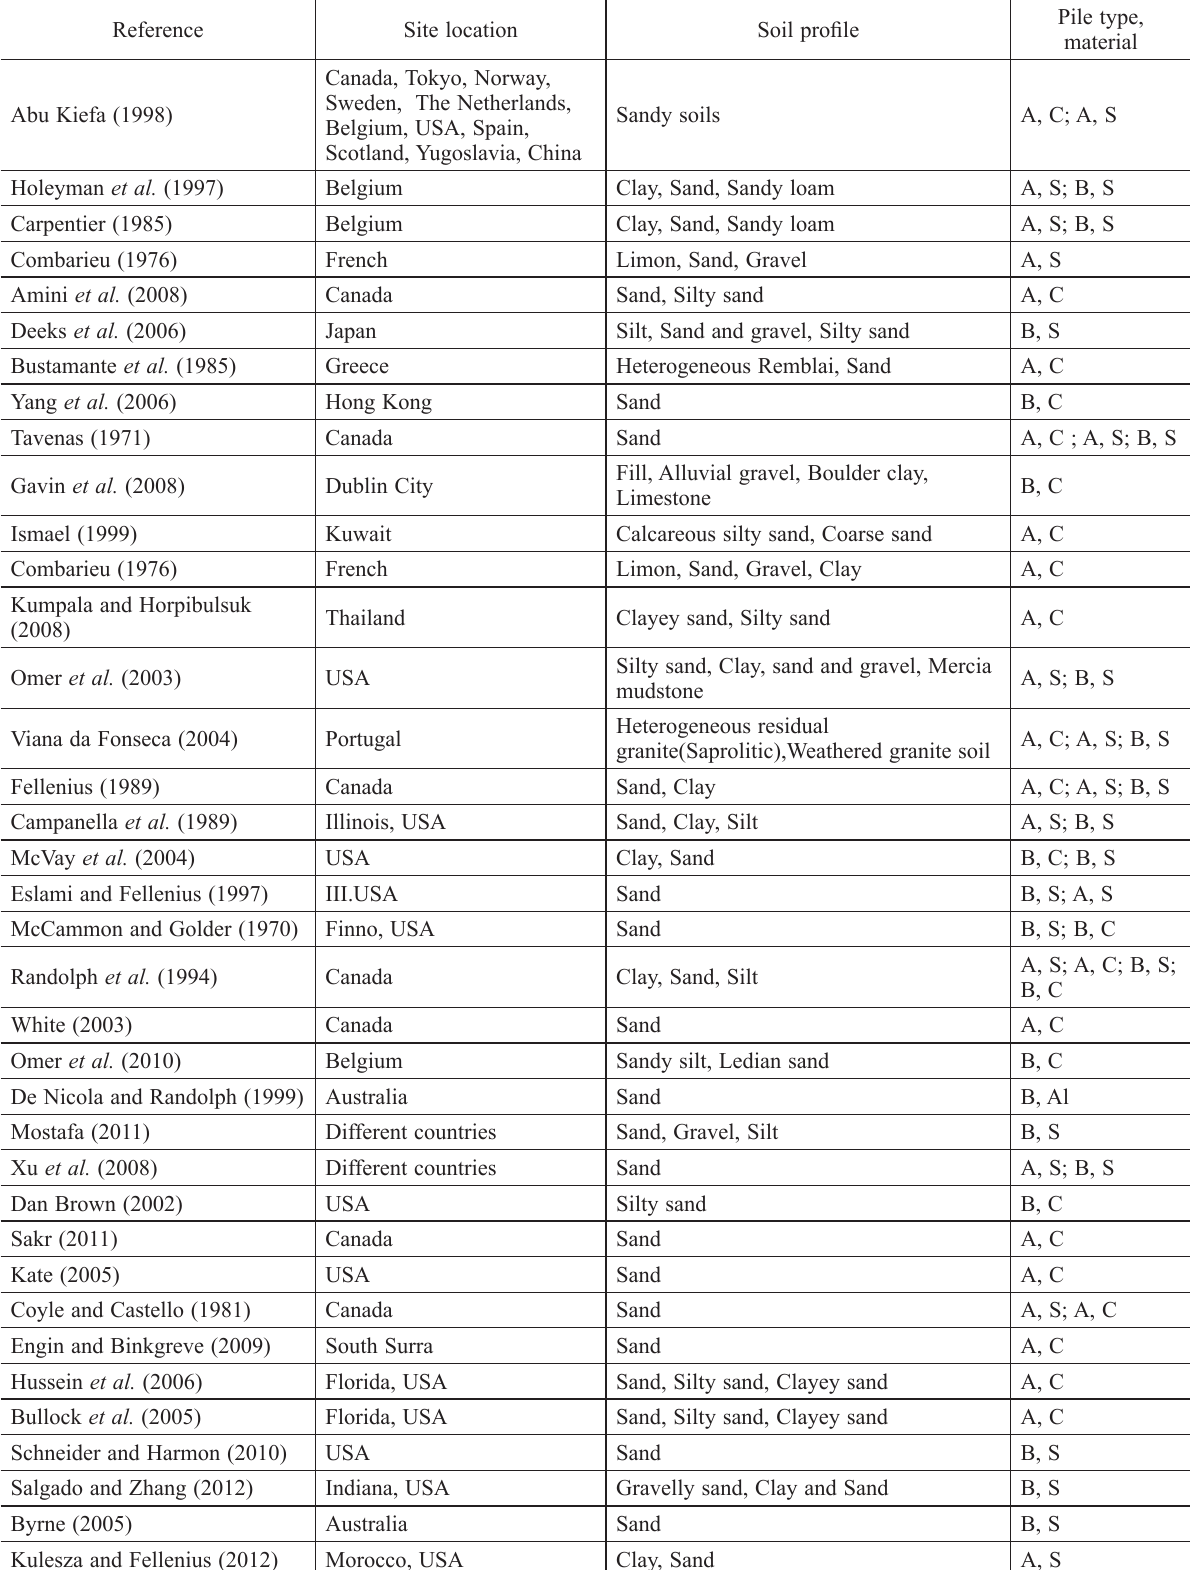
Table A1. Summary of recorded cases (415